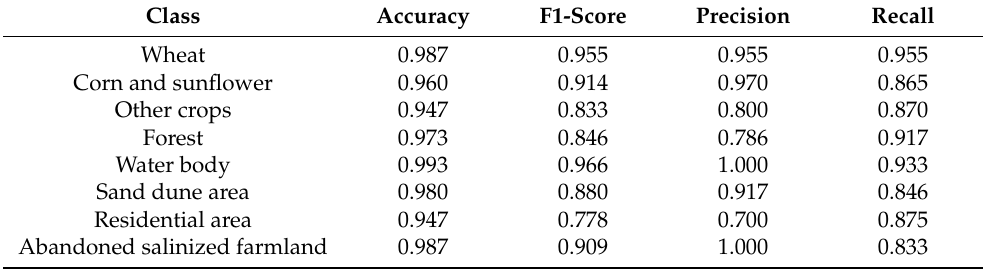
Figure 13. The spatial distribution of the detected abandoned salinized farmland from 1988 to 2018. Table 2. Metrics of land-use classification and abandoned salinized farmland detection results. Class